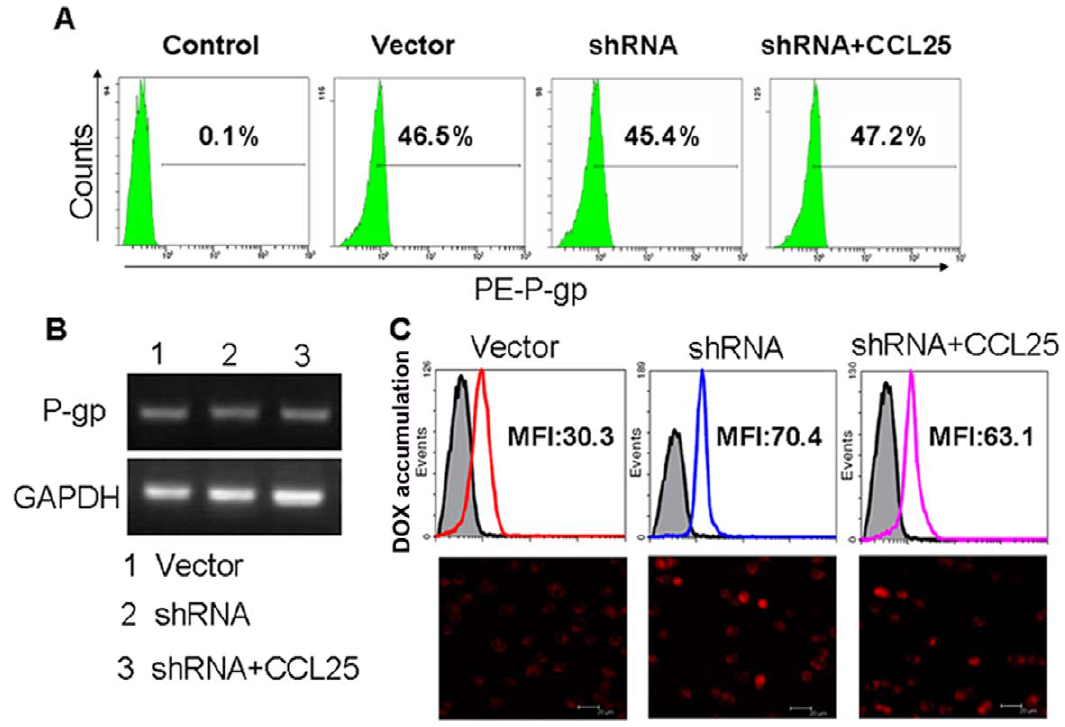
Figure 7. Expression and functionality of P-gp in ERM-silenced MOLT4 cells treated with CCL25. (A) Expression of P-gp by FCM. (B) Expression of P-gp by RT-PCR. (C) DOX accumulation by FCM (upper) and LSCM (bottom). Bar=20 m